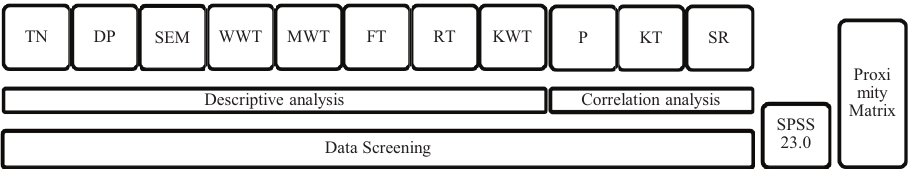
Figure 2. Data collection